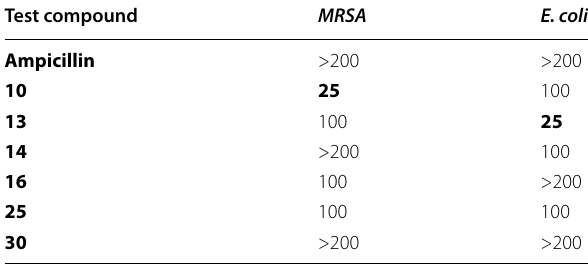
Table 2 Minimum inhibitory concentrations (MIC µg/mL) for clinical isolates of compounds (10), (13), (14), (16), (25) and (30)